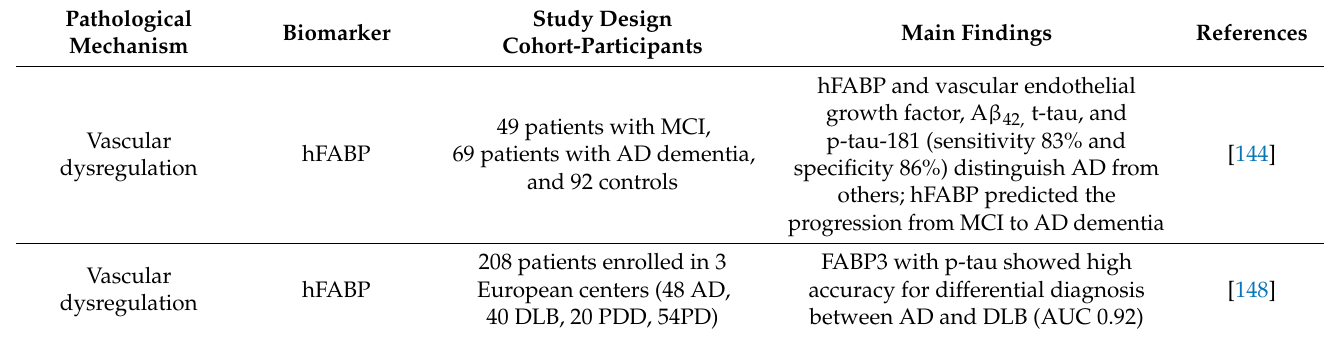
Table 2. Pathological mechanisms (vascular dysregulation and neuroinflammation) and associated biomarkers of Alzheimer’s disease and the findings of related